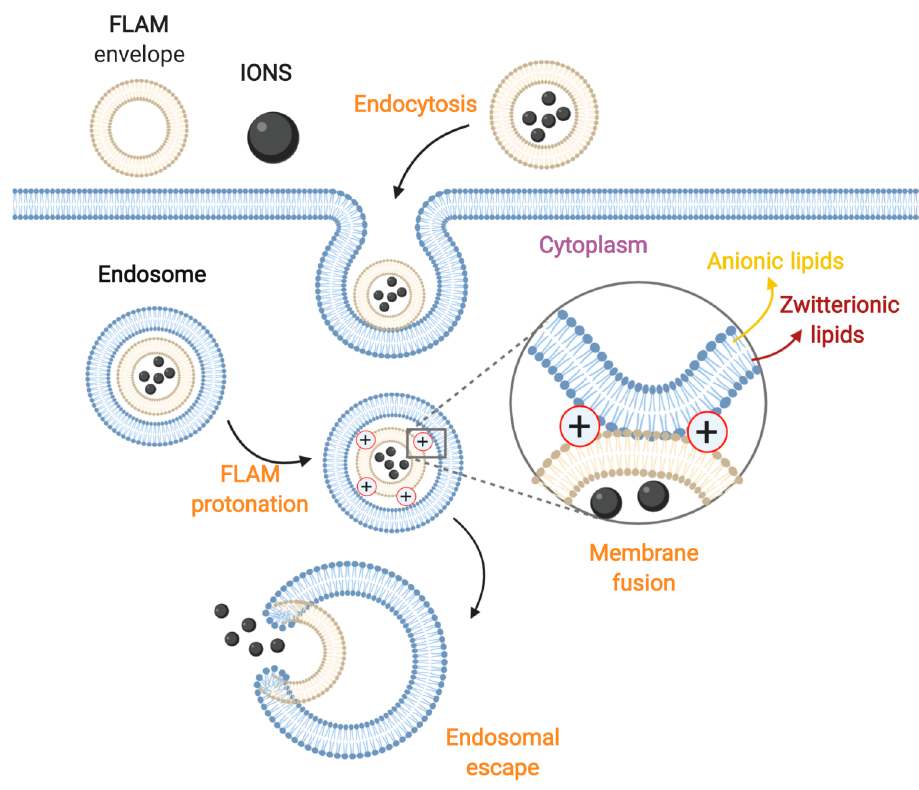
Figure 6. Schematic illustration of the membrane fusion mechanism of fusogenic lipids or amphiphilic molecules (FLAM)-ION complexes. The nanoparticles are encapsulated within a FLAM envelope for subsequent internalization by endocytosis. Within the endosome, the FLAM phospholipids protonate, thereby inducing the fusion of this envelope with the Zwitterionic luminal lipids of the endosomal vesicles. This process ultimately leads to endosomal escape. (Created with BioRender.com).